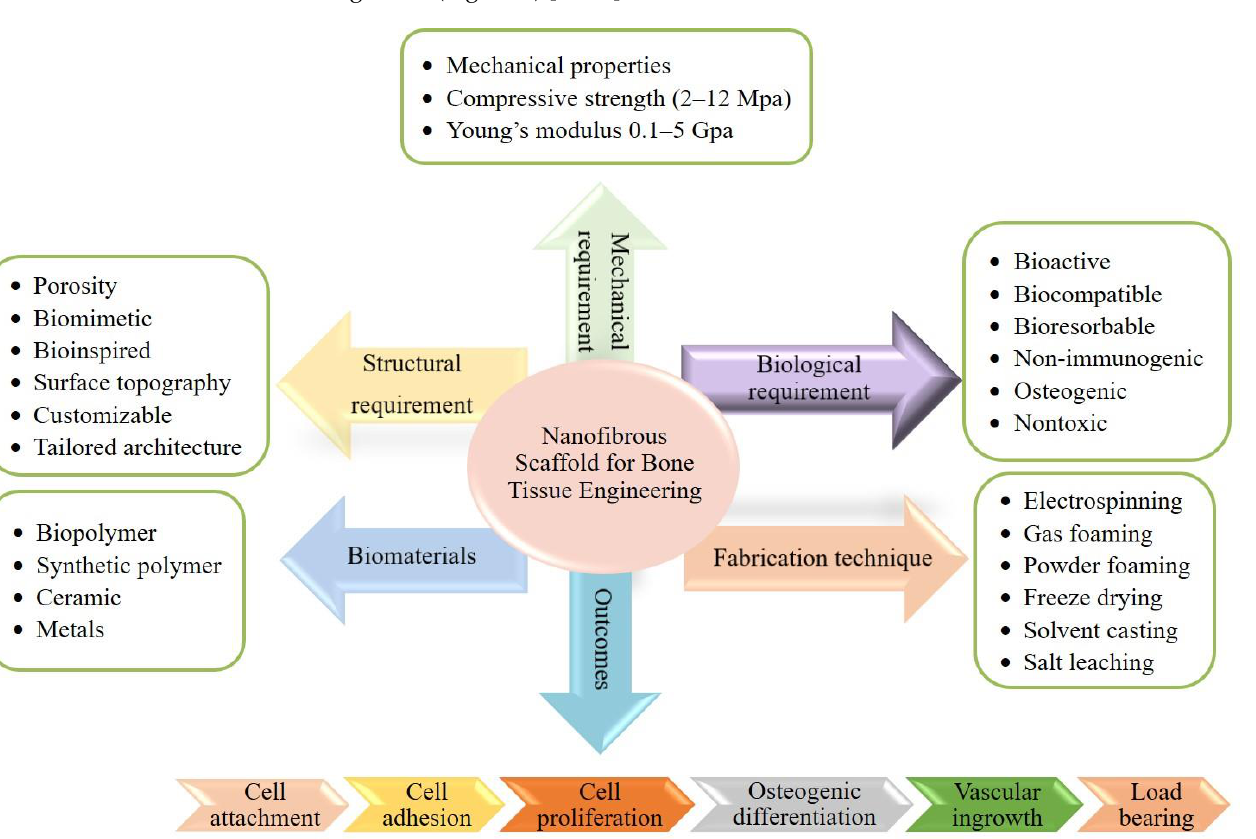
Figure 5. Properties, compositions, synthesis techniques, and outcomes of electrospun nanofiber for bone tissue engineering.